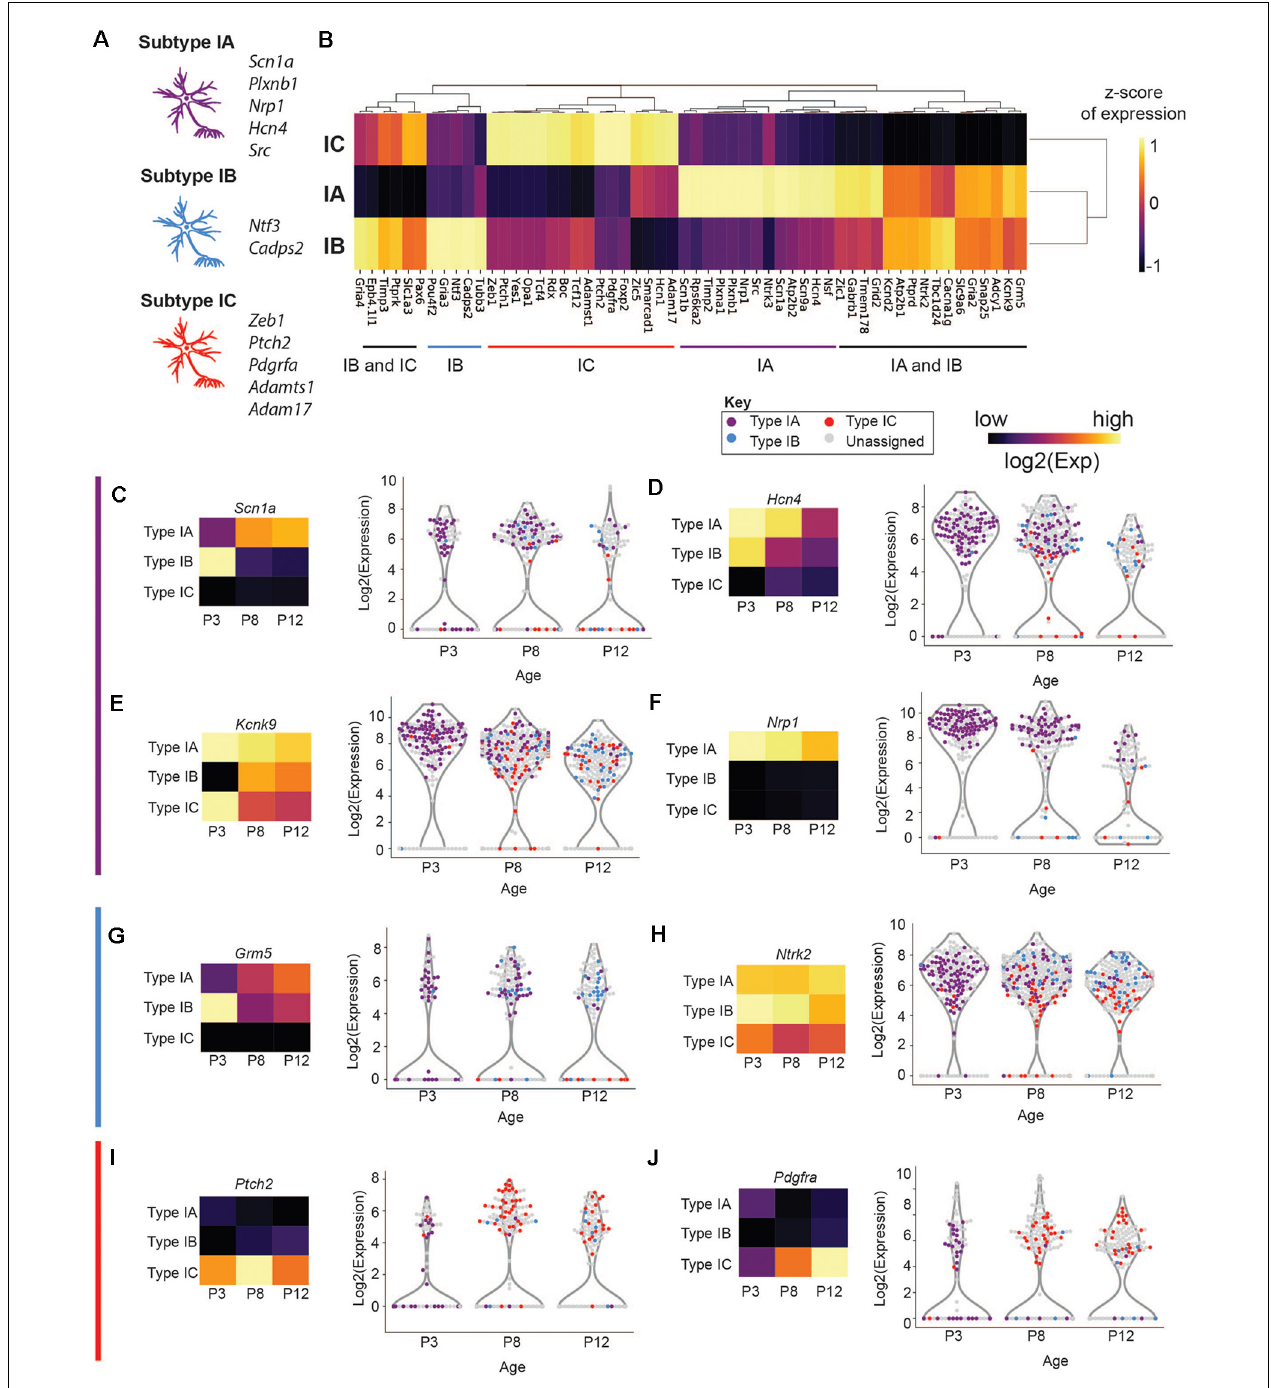
FIGURE 5 | Expression of physiologically relevant genes in SGN Type I subtypes. (A,B) Hierarchical clustering of genes that are differentially enriched in Type I (A,B,C) SGNs and schematic of the most important effectors (on the left). (C–J) Violin plot of (C) Scn1a , (D) Hcn4 , (E) Kcnk9 , (F) Nrp1 , (G) Grm5 , (H) Ntrk2 , (I) Ptch2 , and (J) Pdgfra . Each point represents a single cell, colored according to its subtype or gray if outside the IA, IB, IC. On the left, a heatmap of the same data. Each square has the average expression of cells in that subtype. The expression scale and color key are on the top of the page.